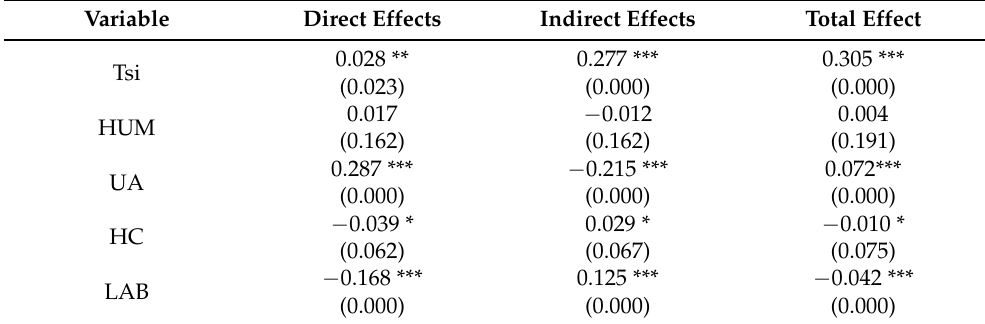
Table 8. Decomposes regression